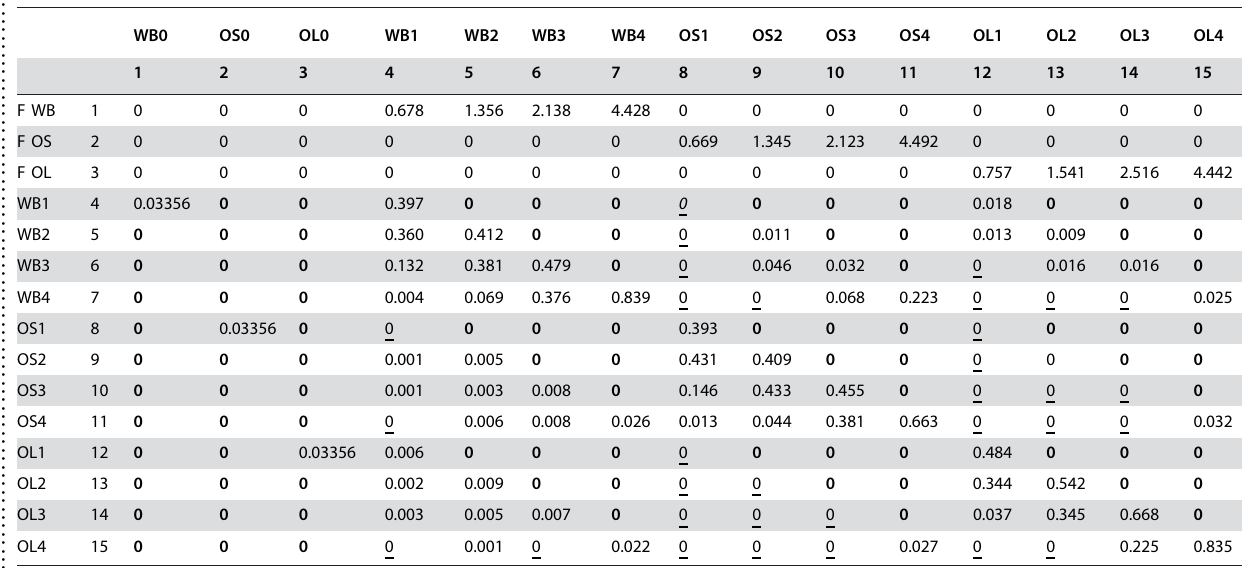
(Table 1). Parametric bootstrap resampling of the reference matrix Table 1. Reference matrix describing monthly size- and location-based survivals and fecundities (F in rows 1–3) for the West brook (WB) and OpenSmall (OS) and OpenLarge (OL) tributaries. .. ... .... ... ... .... ... ... .... ... ... .... ... ... .... ... ... .... ... ... .... ... ... .... ... ... .... ... ... .... ... ... .... ... ... .... ... ... .... ... ... .... ... ...